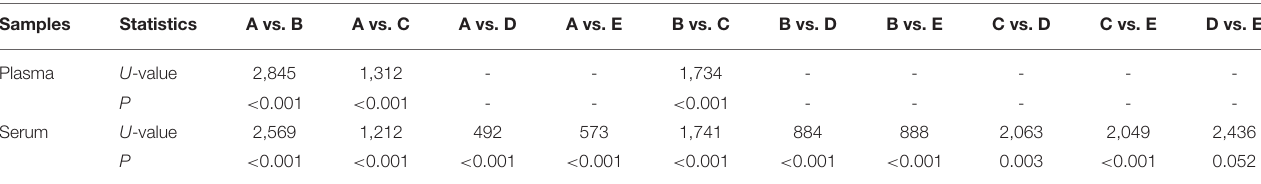
TABLE 2 | Levels of NETs in PB samples from groups of participants.